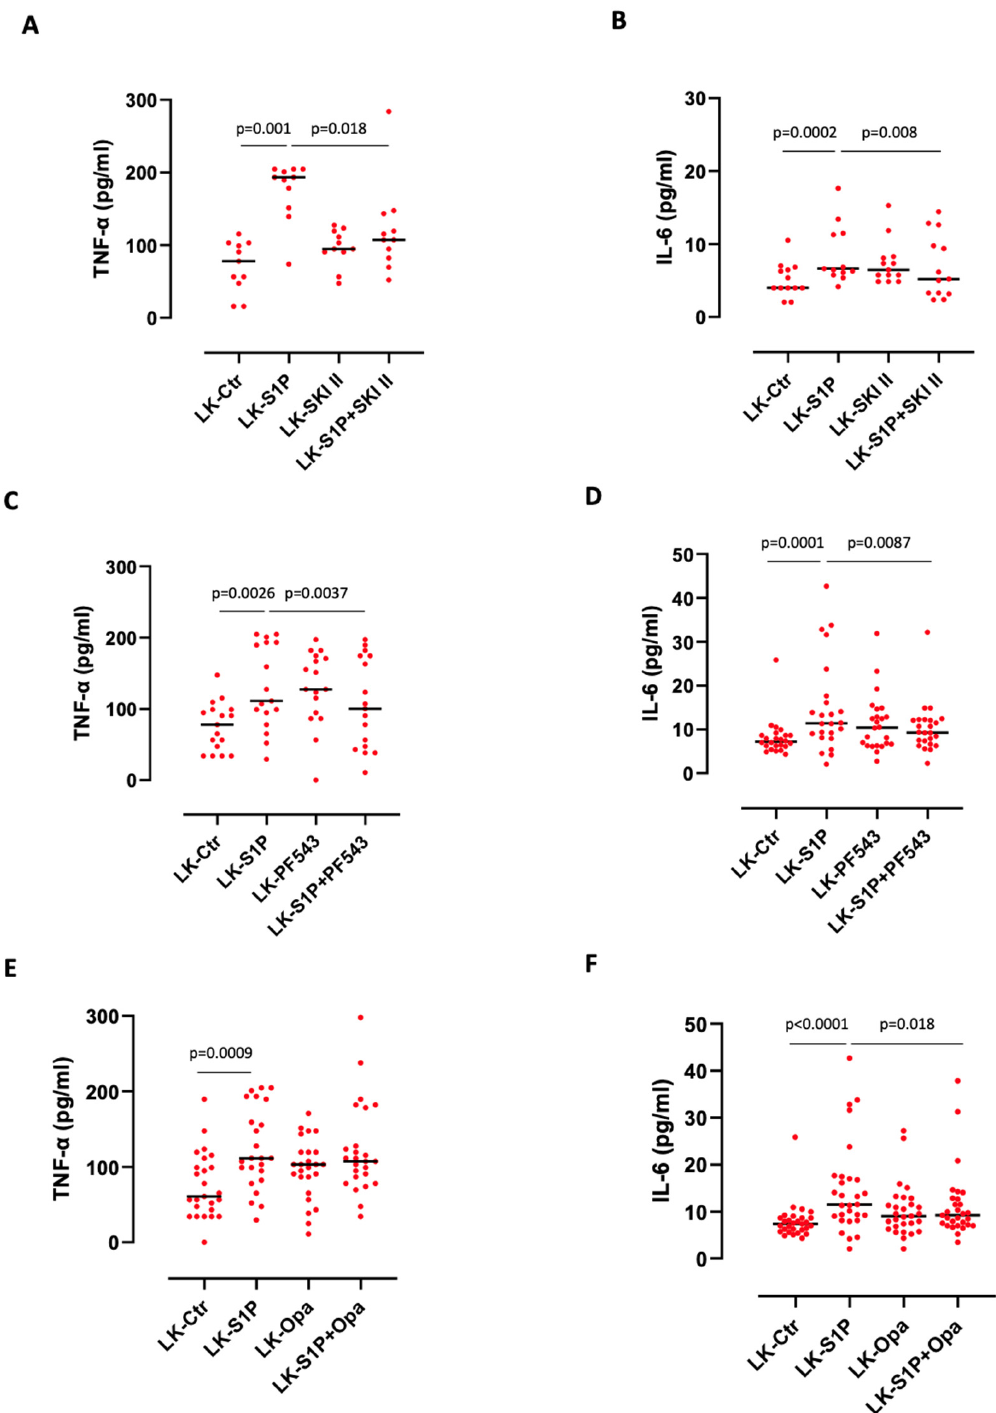
Figure 4. Sphingosine kinase inhibition reduced S1P-induced pro-inflammatory cytokine release. The inhibition of both SPHK I and II by means of SKI II (10 µ M) reduced S1P-induced TNF- α (( A ), n = 11) and IL-6 (( B ), n = 13) release from lung cancer (LK)-derived matched-pairs PBMCs. The inhibition of SPHK I by means of PF543 (2 µ M) reduced S1P-induced TNF- α (( C ), n = 17) and IL-6 (( D ), n = 24) release from LK-derived PBMCs. The inhibition of SPHK II by means of Opaganib (Opa, 60 µ M) reduced S1P-induced IL-6 (( F ), n = 29), but not TNF- α (( E ), n = 25), from LK-derived PBMCs. Data are represented as scatter dot plots indicating the median (confidence interval = 95%). Statistical differences were assessed by means of a two-tailed Wilcoxon matched pairs signed rank test.